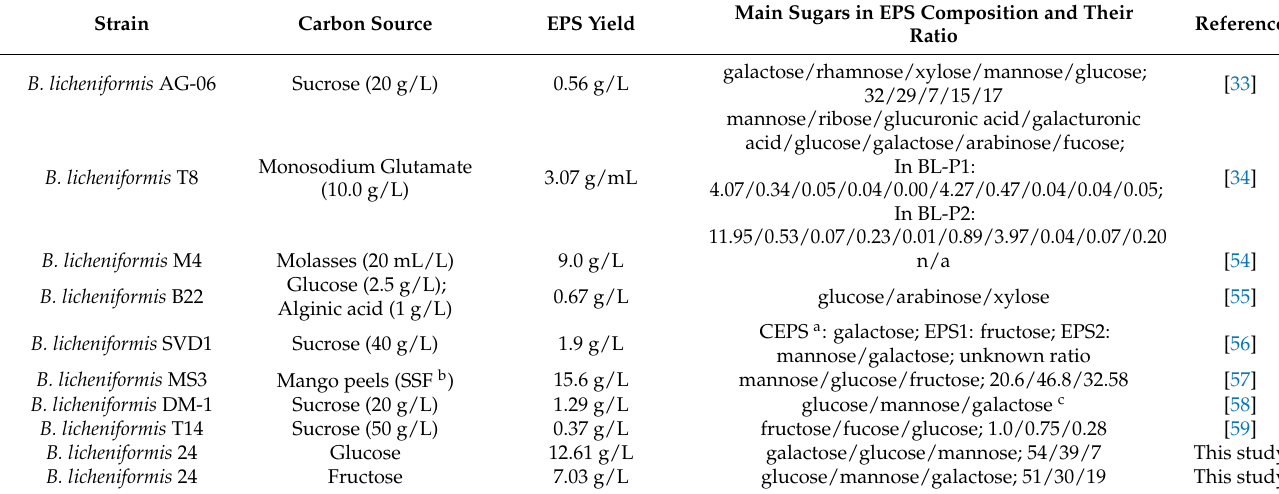
Table 2. Comparison of EPS produced by B. licheniformis